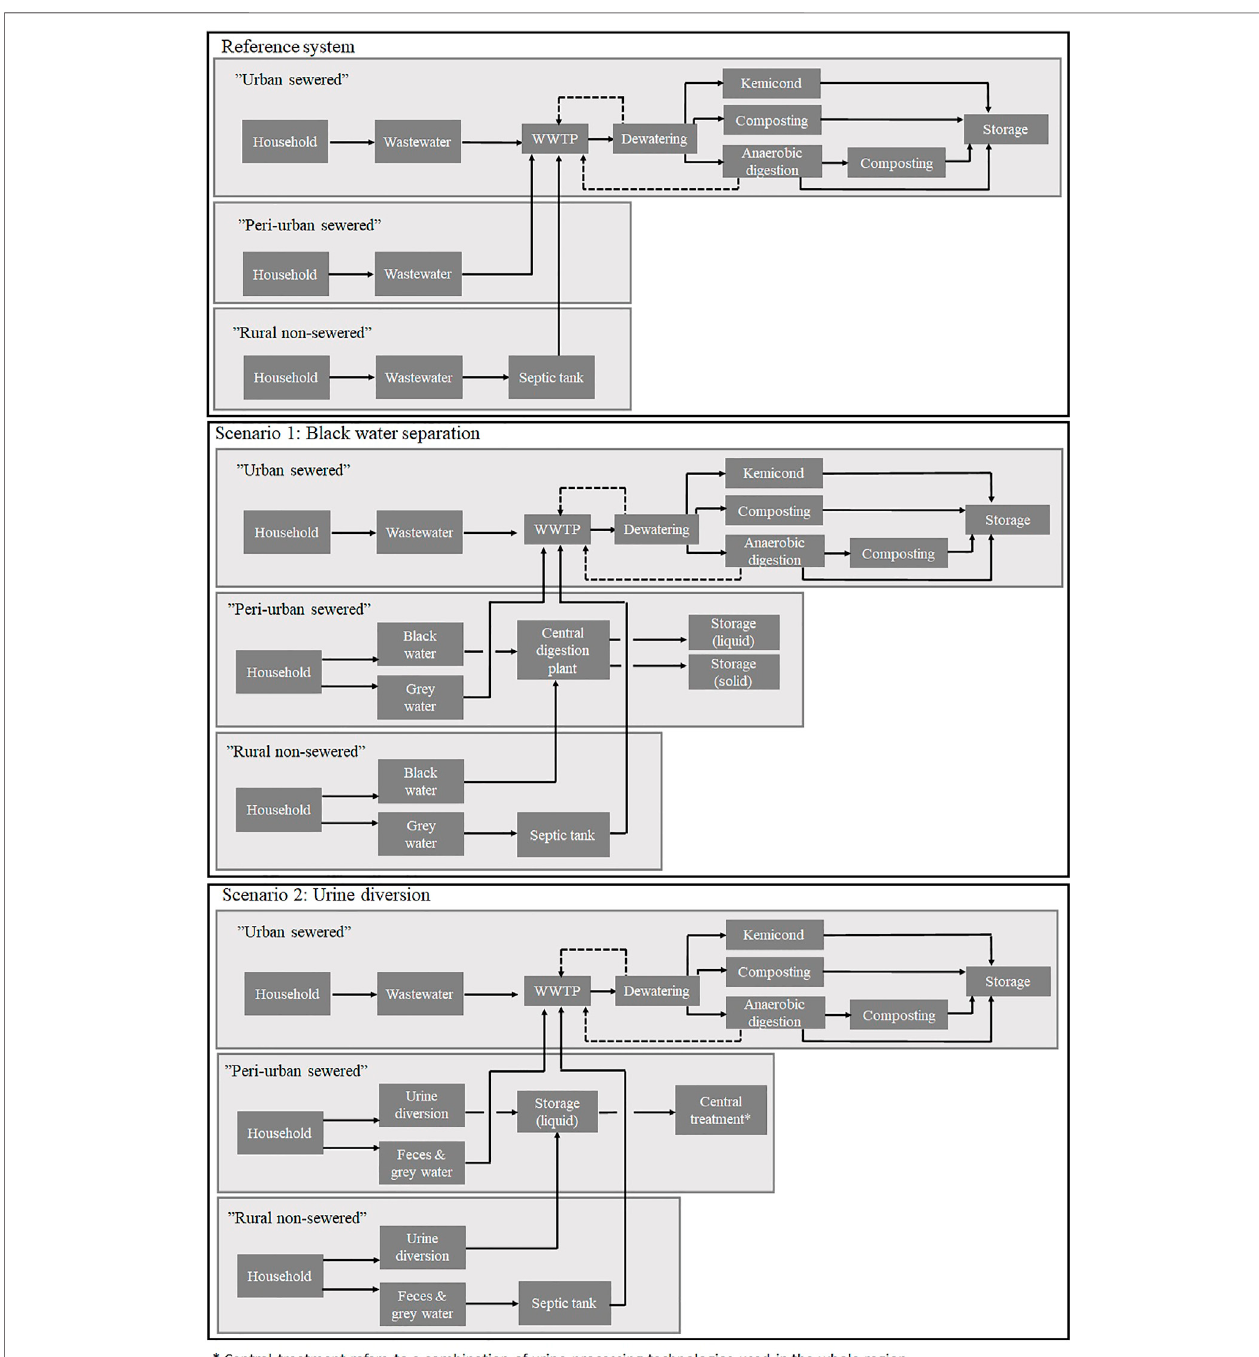
FIGURE 1 | Flowcharts of reference system and the de fi ned Scenarios 1 and 2. Solid lines represent the wastewater and wastewater-based nutrient fl ows in the system. Dashed lines represent reject waters. The distribution of WWTPs sludge treatment in the three regions studied is presented in Table 1 .